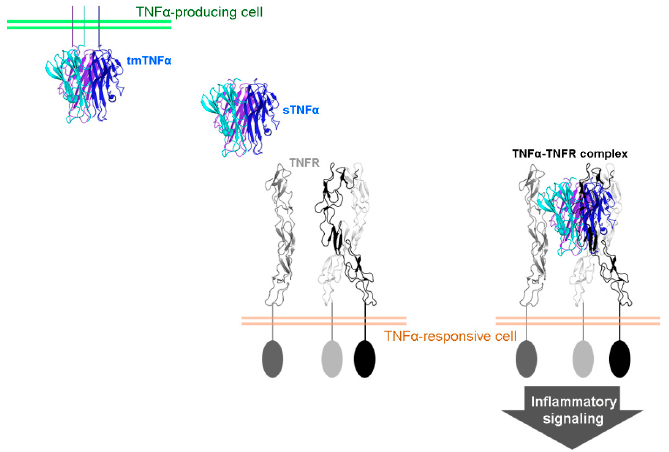
Figure 1. Biology of tumor necrosis factor α (TNF α ). A soluble TNF α (sTNF α ) trimer is